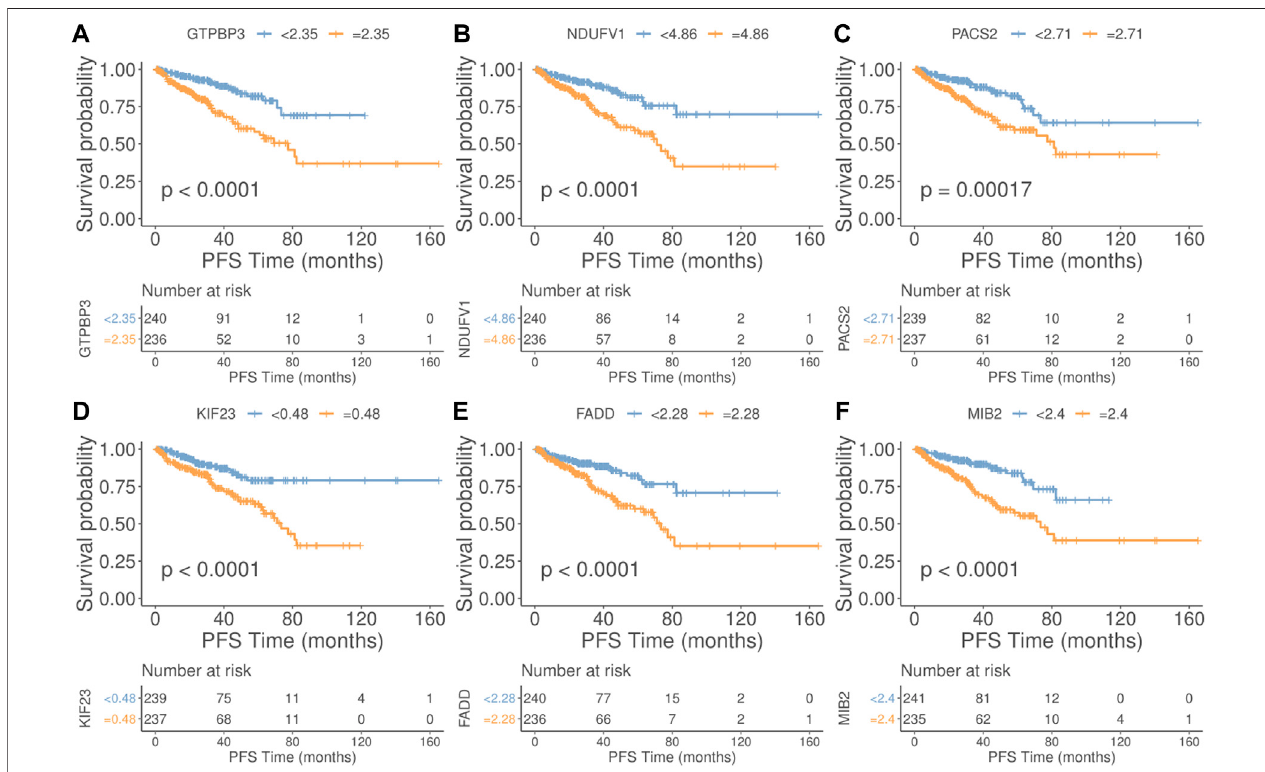
FIGURE 3 | Relationship between the top 6 phagocytic factors and prognoses in PRAD. (Upper part of fi gure: Patient ’ s survival probability between different expression group at different PFS times; Vertical axis: Survival probability; Horizontal axis: PFS Time; Lower part of fi gure: Number of cases in different gene expression groups at different PFS Times. (A) GTBP3, (B) NDUFV1, (C) PACS2, (D) KIF23, (E) FADD, and (F) MIB2. ( p < 0.0001, p < 0.0001, p = 0.00017, p < 0.0001, p < 0.0001, p < 0.0001, and p < 0.0001,